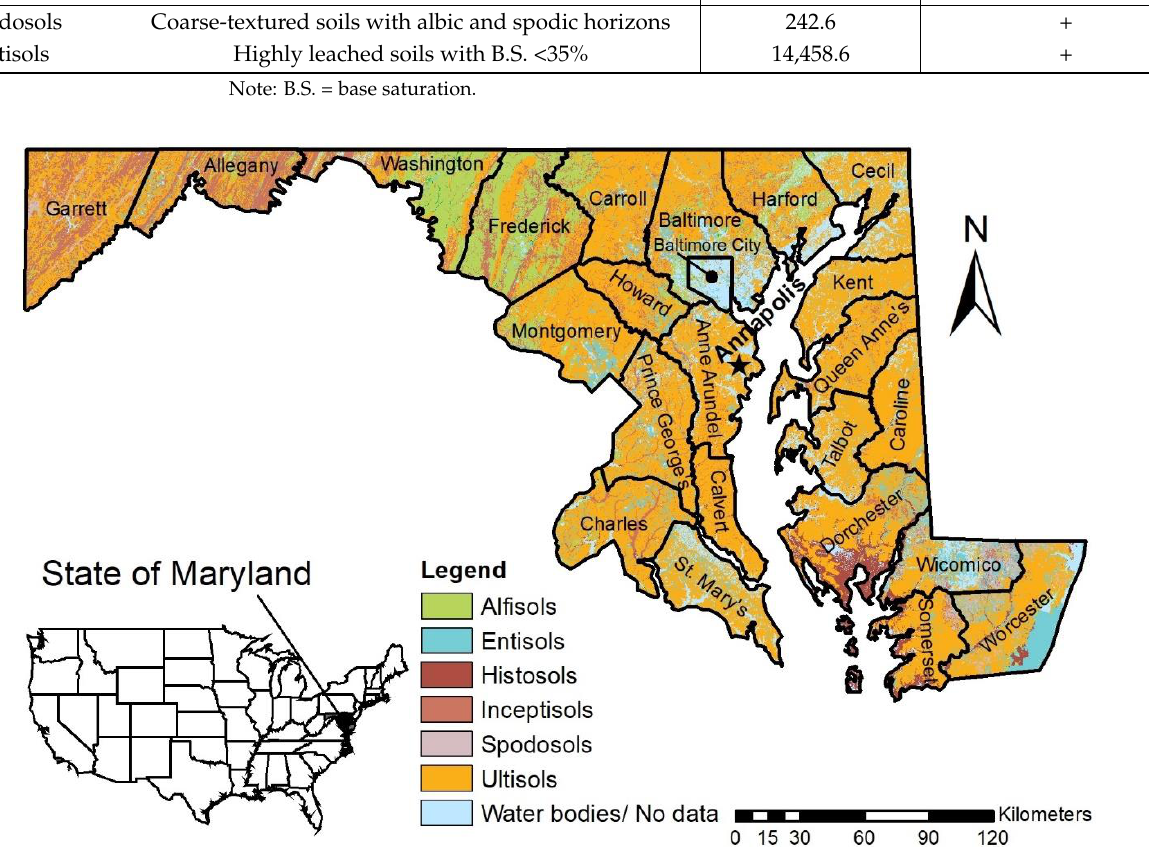
Figure 2. General soil map of Maryland, USA (37°53 ′ N to 39°43′ N; 75°03′ W to 79°29′ W) based on the SSURGO soils database [9] with counties boundary shown [10].